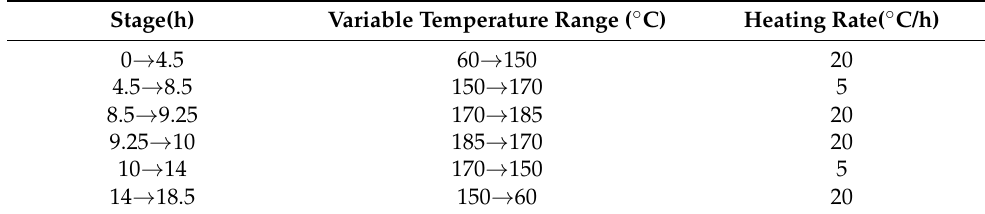
Table 3. The processing steps of non-isothermal